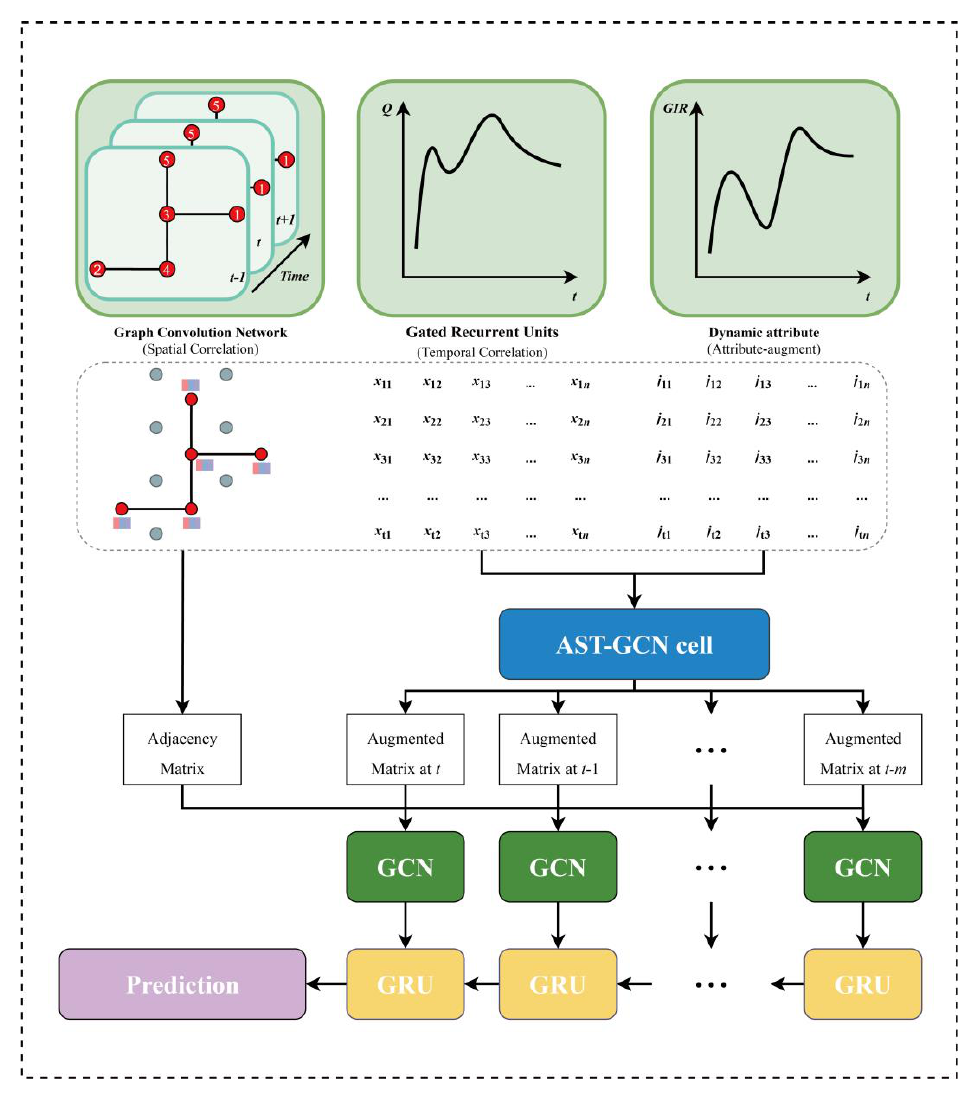
Figure 4. The structure of AST-GCN in this paper.